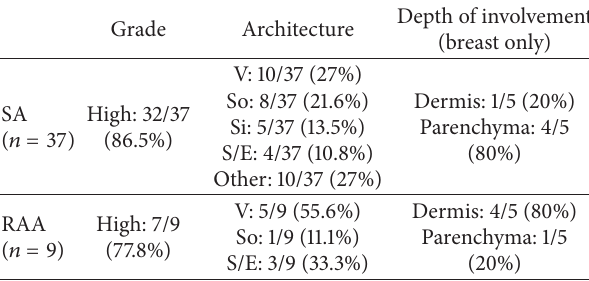
Table 2: Histological comparison between SA and RAA.